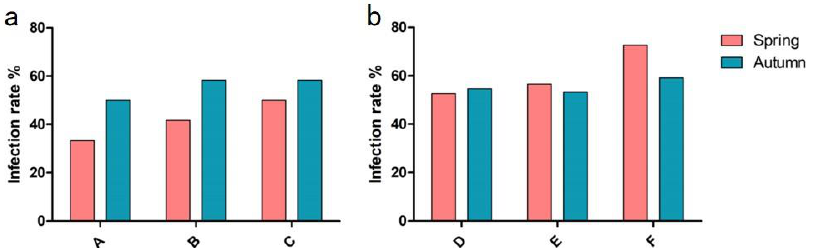
Figure 1. Infection rate of Nematodirus in Hulunbuir ( a ) and Xilingol Grasslands ( b ) before the spring and autumn deworming. and autumn